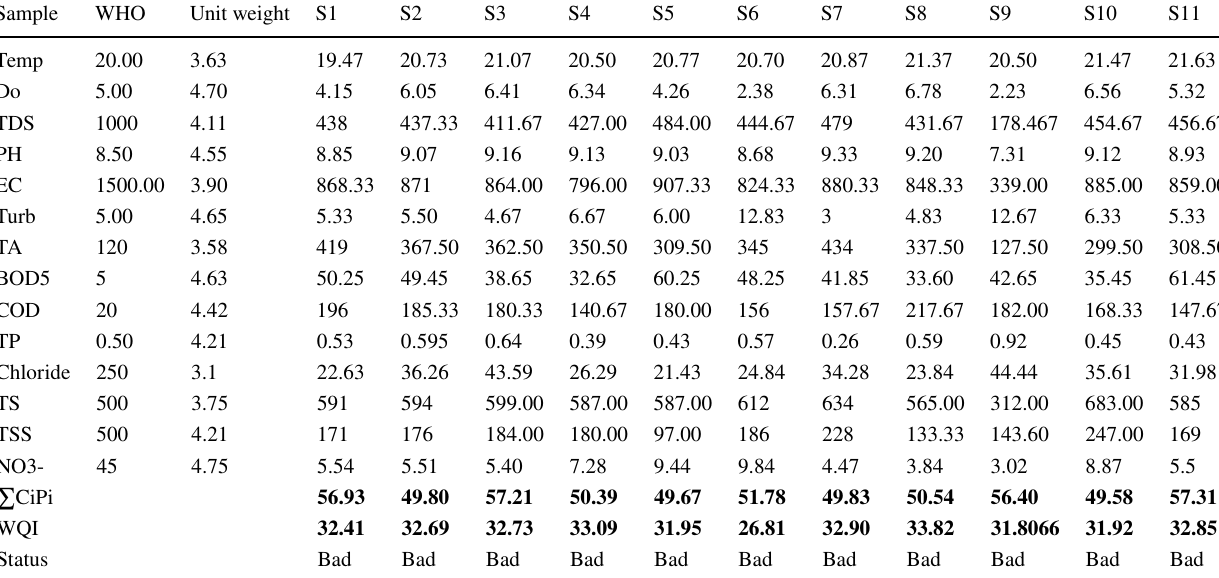
Table 4 Modified Bascarón water quality index